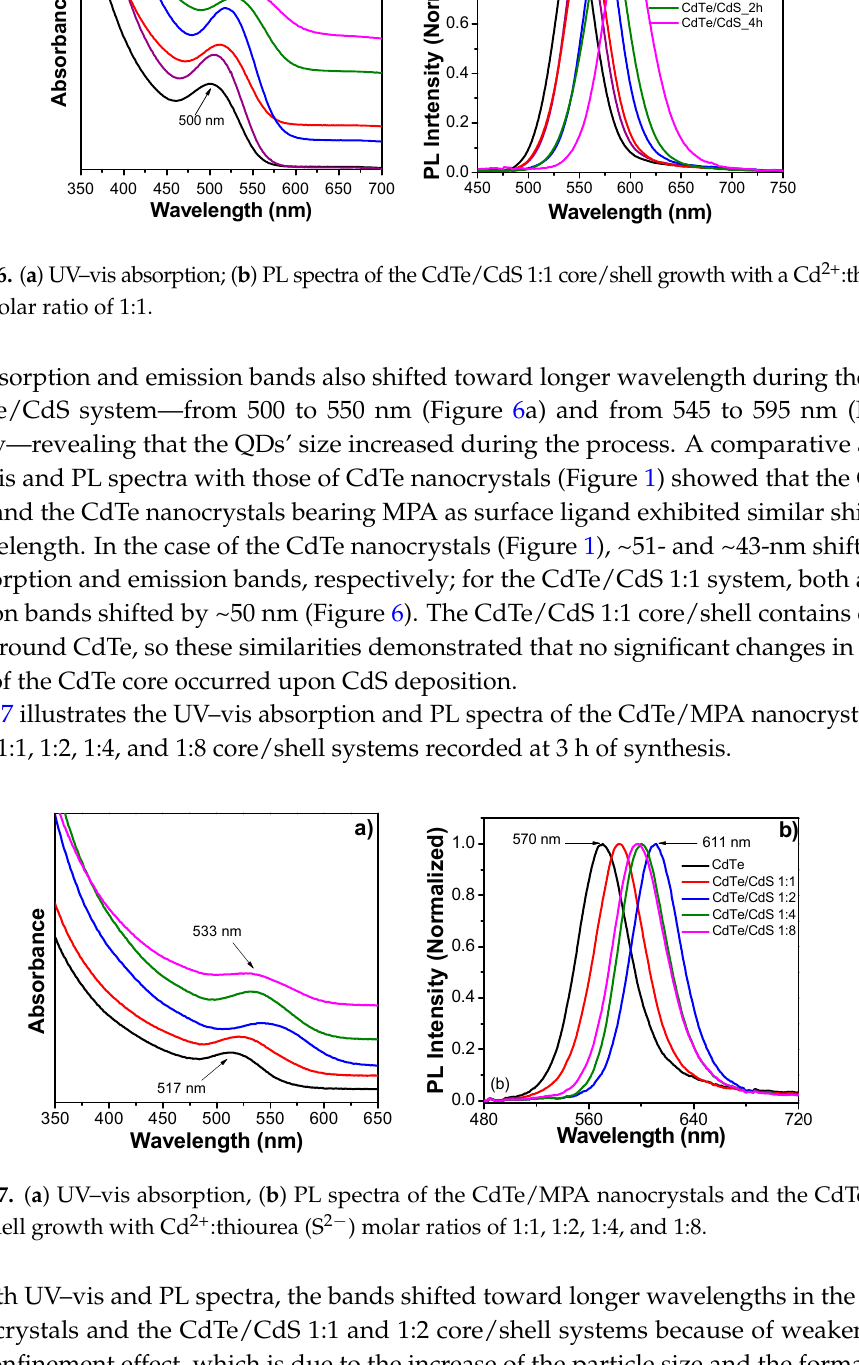
Figure 6. ( a ) UV–vis absorption; ( b ) PL spectra of the CdTe/CdS 1:1 core/shell growth with a Cd 2+ :thiourea (S 2 − ) molar ratio of 1:1.